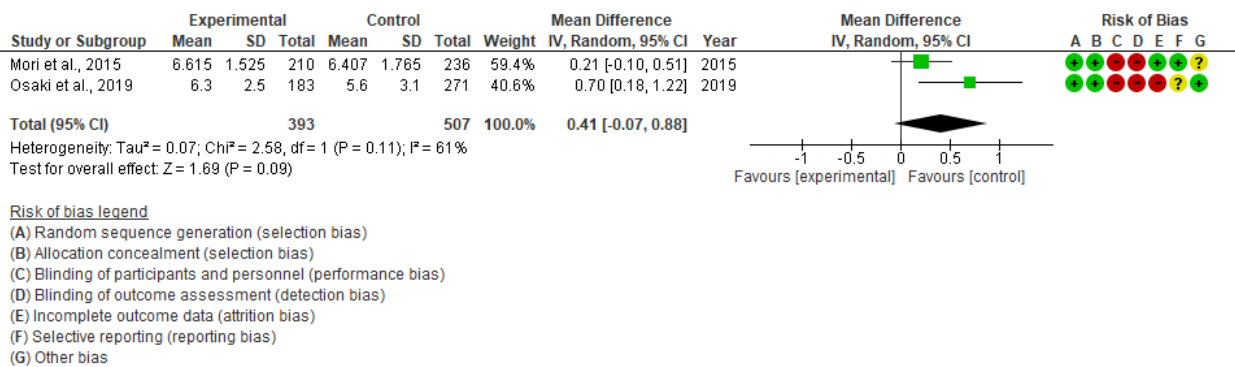
Figure 5. Meta-analysis for the effect of MCH handbook interventions vs. standard care on mean number of ANC visits [19,20]. Red color with a − symbol means a high risk of bias, yellow color with a ? symbol means an unclear risk of bias, and green color with a + symbol means a low risk of